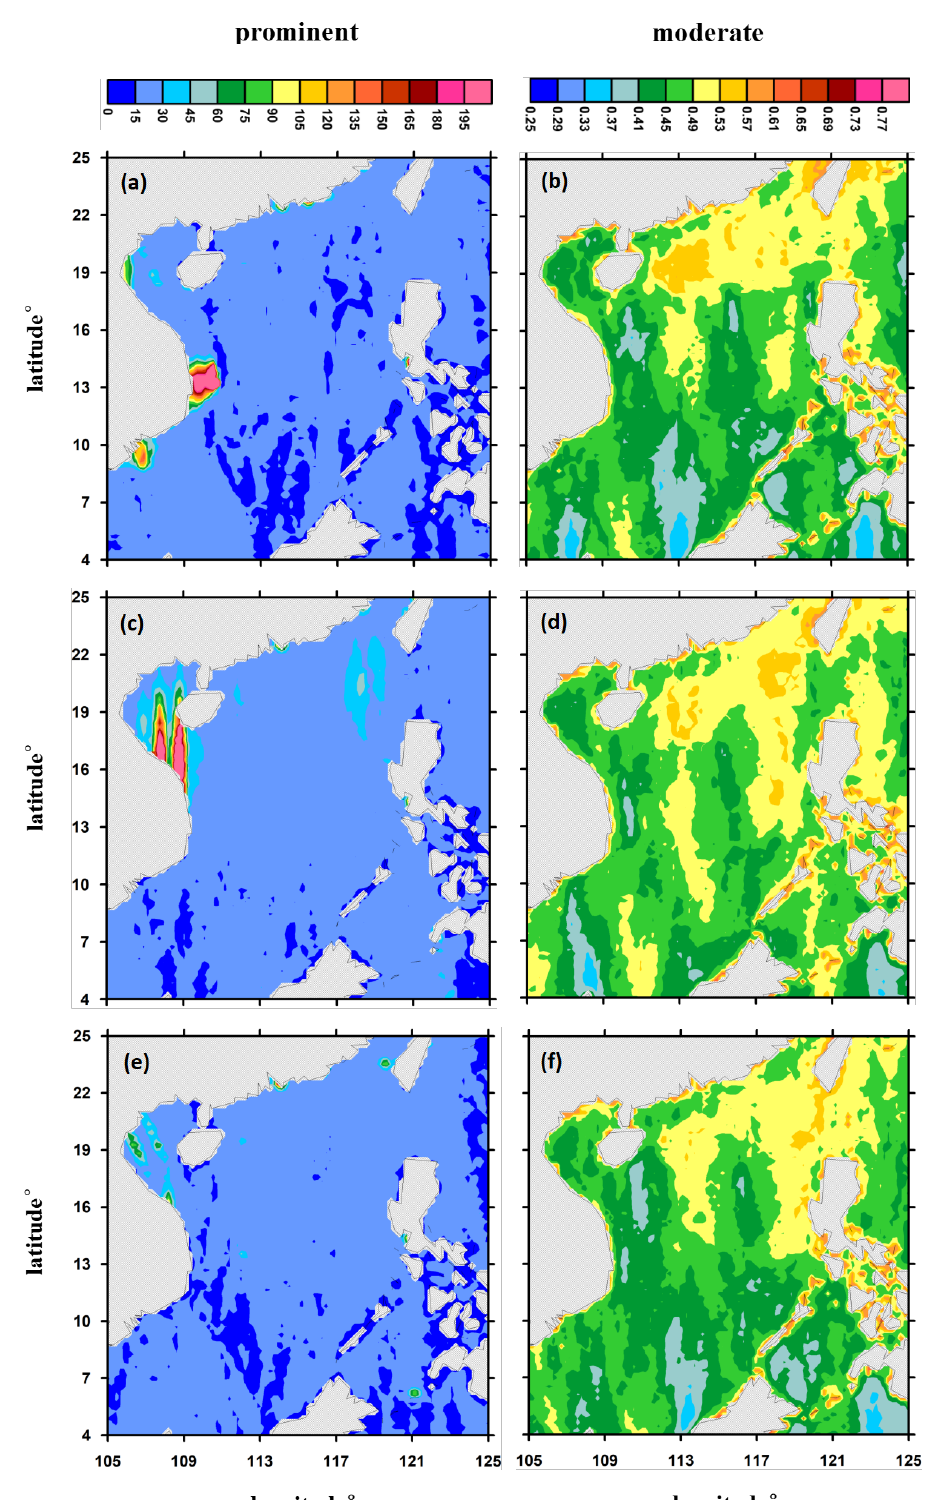
Figure 7. The 9-day merged RFI map. The prominent RFI maps ( a , c , e ) and the moderate RFI maps ( b , d , f ) are merged RFI maps of 9 days, presenting contamination in three different periods. Among them, ( a , b ) are RFI condition during 11 to 19 June 2018, ( c , d ) are for the time from 11 to 19 September 2018, and ( e , f ) are for the time from 12 to 20 December 2018. All images have been truncated to SCS region. The light gray in the images represents the land